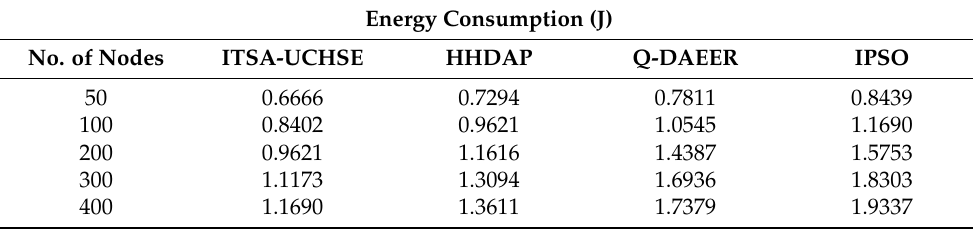
Table 1. ECON analysis of ITSA-UCHSE system with existing approaches under distinct